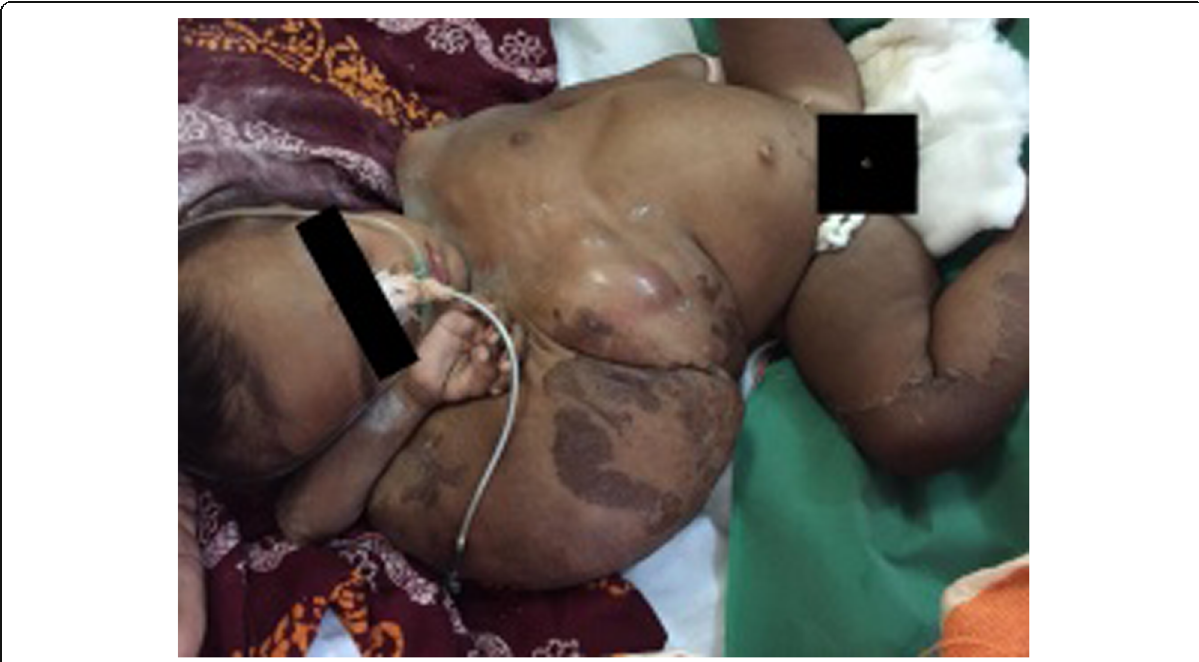
Fig. 1 An 18-month-old child having restricted neck extension due to huge cystic hygroma involving the neck and